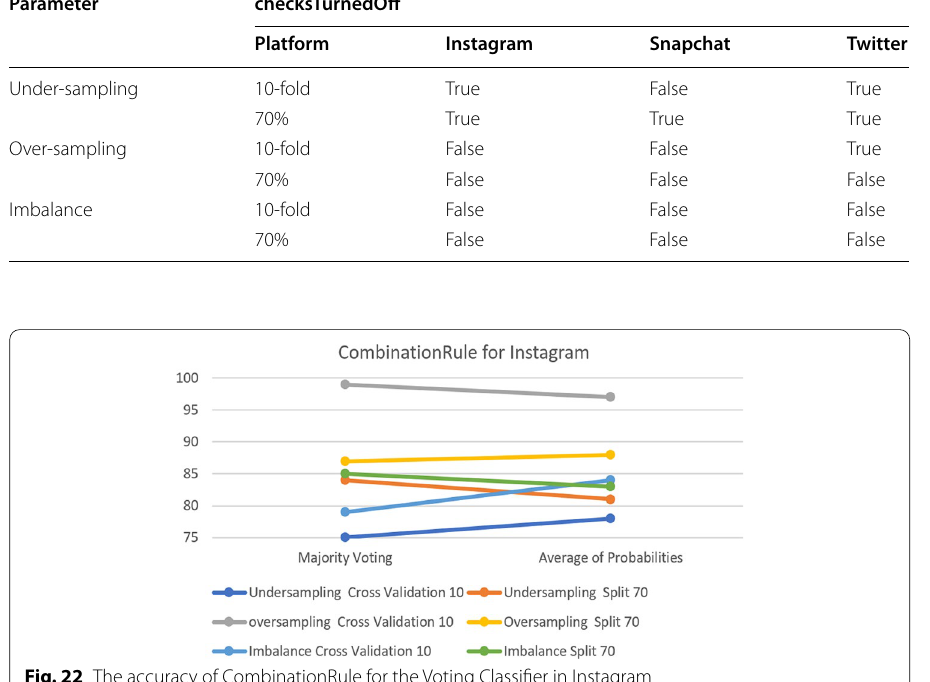
Table 8 Optimal parameter for the SVM model Parameter